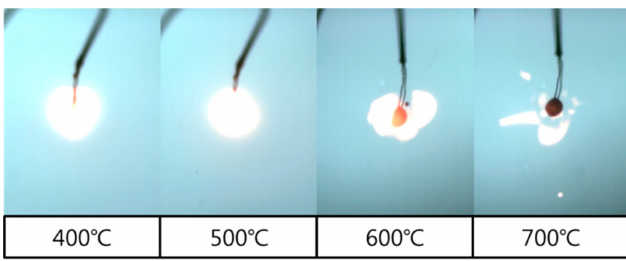
Figure 12. Flame configuration at an emulsion droplet ignition at various ambient temperatures.